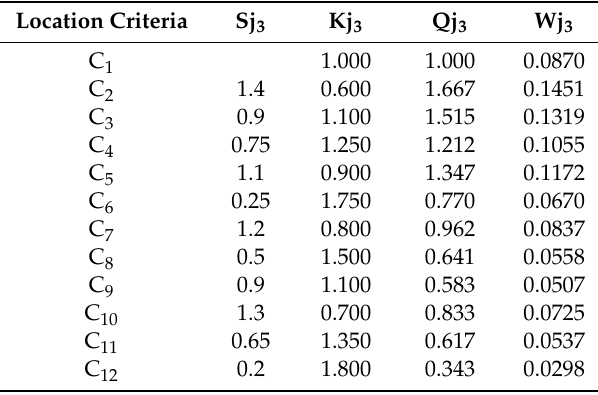
Table 13. Response of the third member of the EE